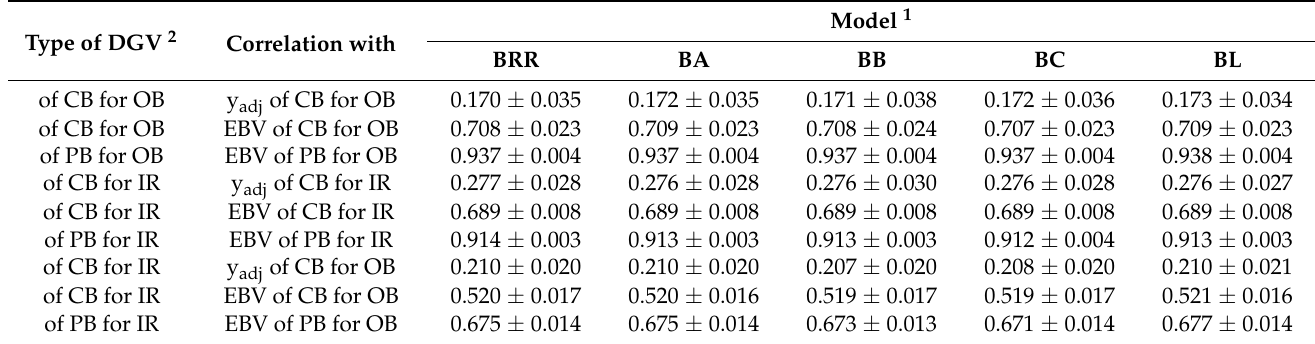
Table 3. Correlations ( ± SE) between direct genomic values (DGV) and pre-corrected phenotypes (y adj ) or estimated breeding values (EBV) for observed (OB) and infrared-predicted (IR) ham weight loss estimated in the 5-fold cross-validation for different